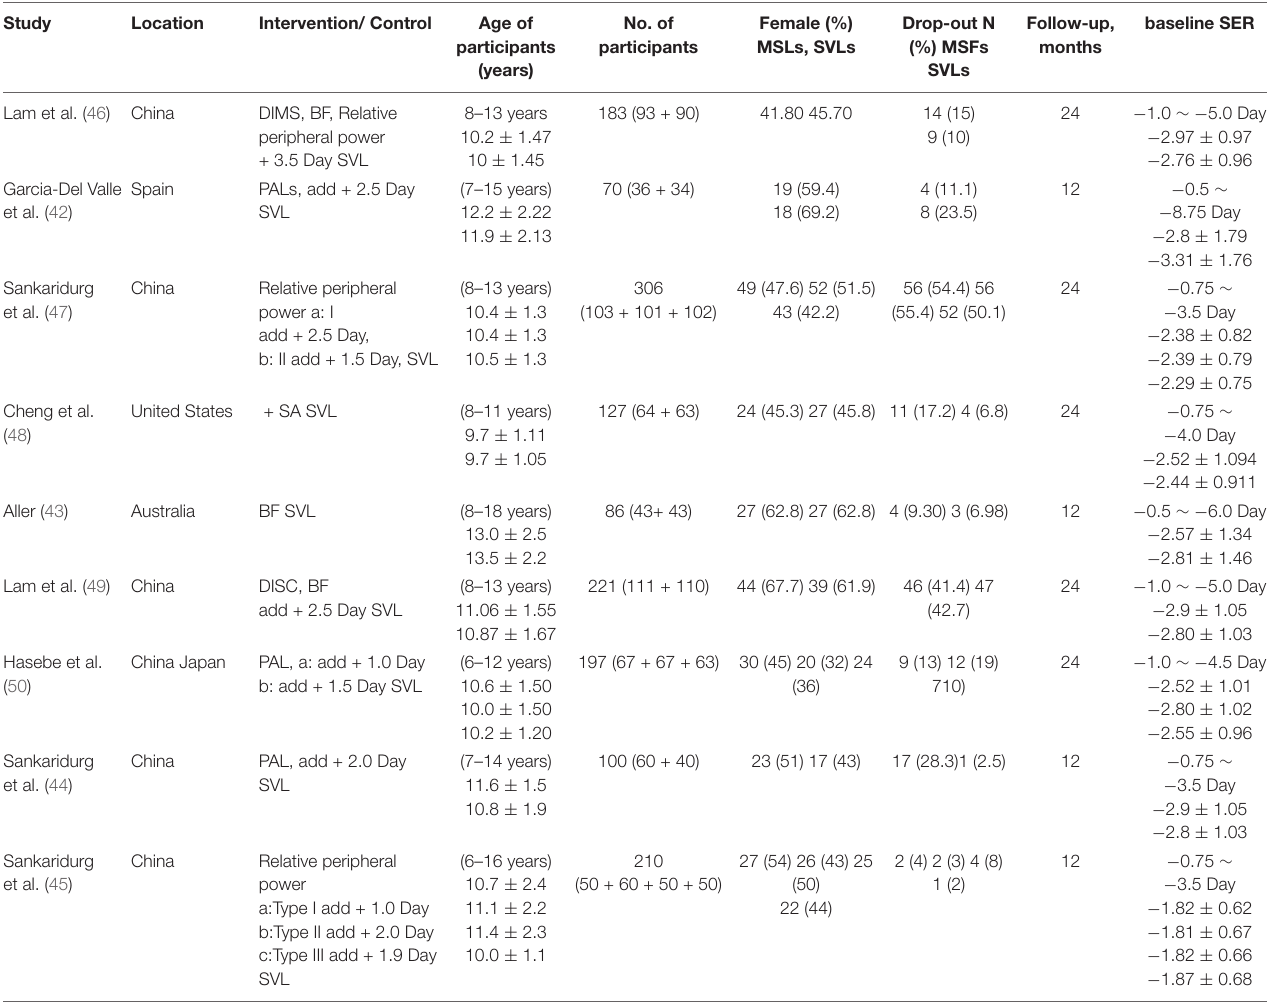
TABLE 2 | Characteristics of included 6-months visit studies in